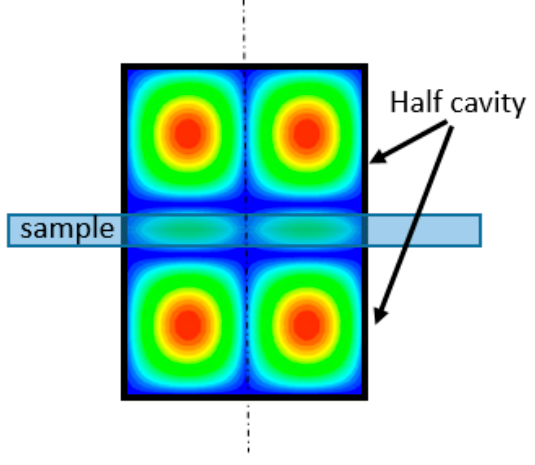
Figure 2. Split resonant cavity.